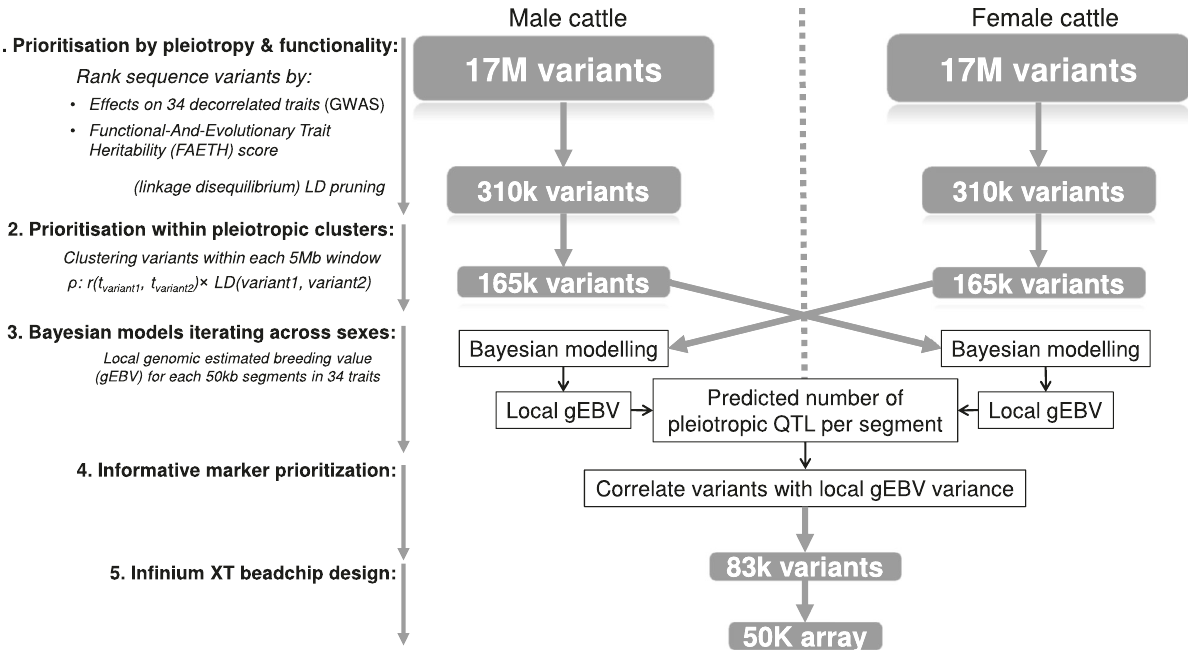
Fig. 1 Overview of the 5-step genome-wide fi ne-mapping analysis with 34 traits. Steps 1 – 2 that prioritised variants based on the multi-trait GWAS and functional information were conducted separately in the male and female cattle. The design of the Bayesian mixture modelling across two sexes (step 3) aimed at avoiding the bias of variant preselection and is detailed in Supplementary Note 1. Variant effects from Bayesian models were used to calculate local gEBV for each 50 kb segment. Different sets of local gEBV allowed the estimation of the predicted number of pleiotropic QTL per segment. Within each segment, variants with the highest correlation with the local gEBV variance were selected (step 4). These variants were used to customise the XT- 50K bovine genotyping array (step